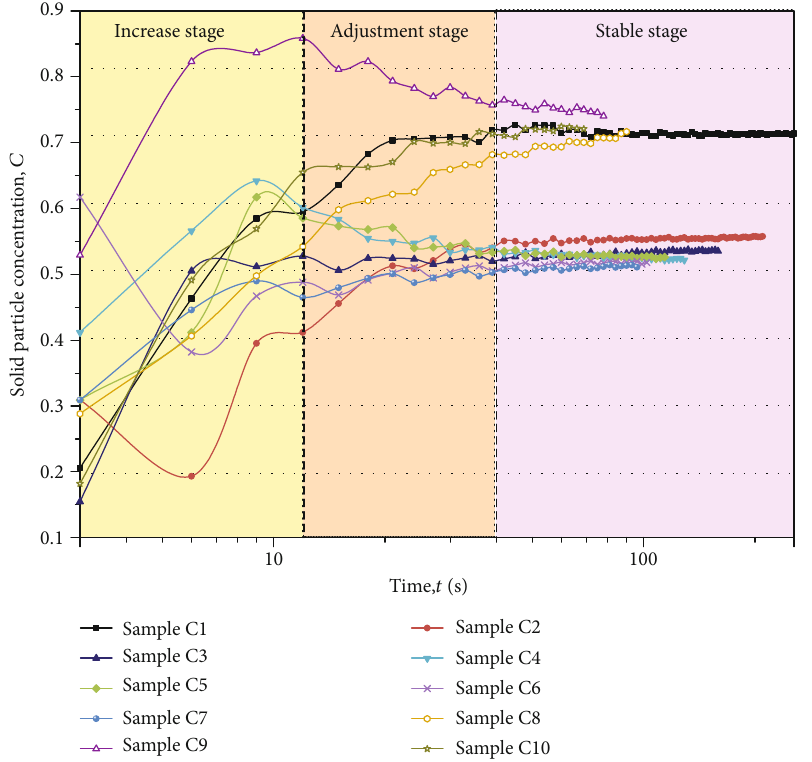
Figure 13: The evolution of solid volumetric concentration with time for di ff erent